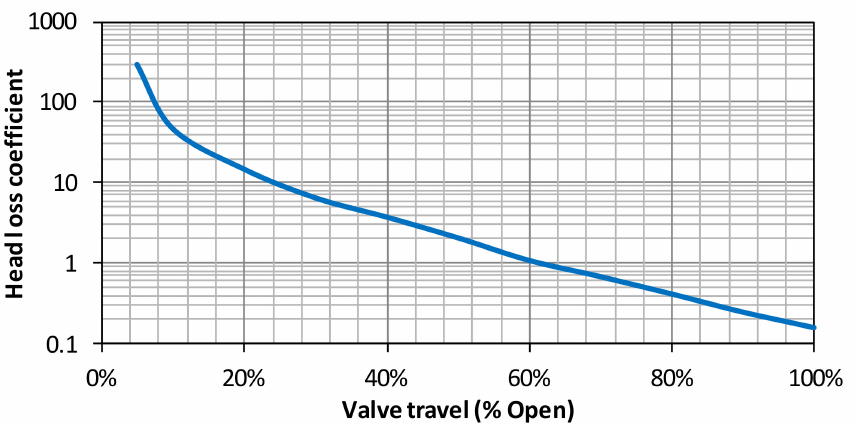
Figure 2. Head loss coefficient as a function of valve travel.